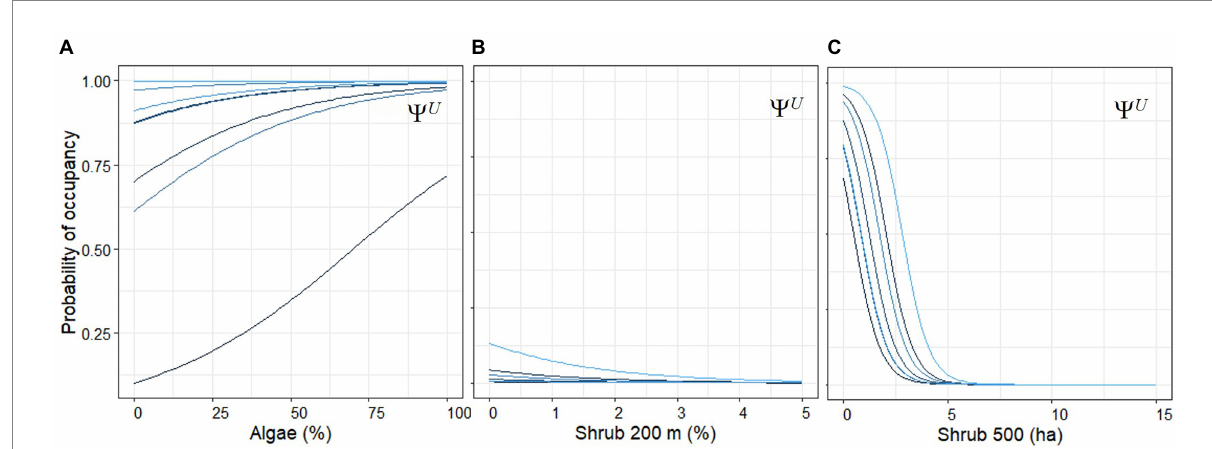
FIGURE 6 Empirical Bayes plots of the marginal occupancy probability of Umpqua chub present given no bass with (A) percent algae, (B) the percent of shrub in a 200 m width, variable area buffer, and (C) area of shrub cover in a 500 m radius buffer assuming averages for the other covariates in the model from 2006 to 2021 snorkel surveys. Each blue colored line represents a watershed in the Umpqua Basin, Oregon, United States.